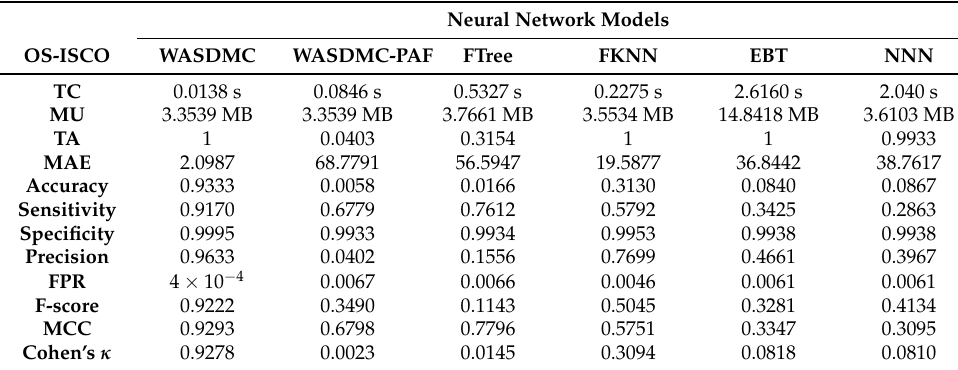
WASDMC WASDMC-PAF